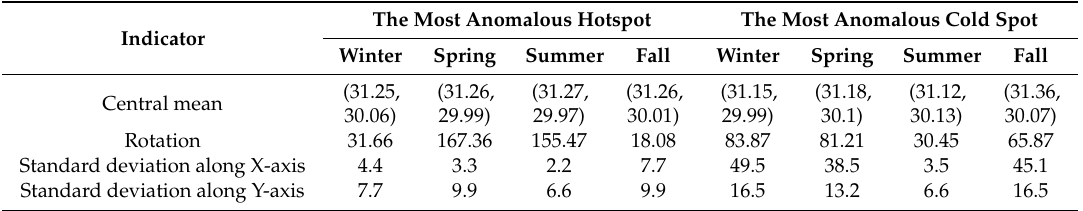
Standard deviation along